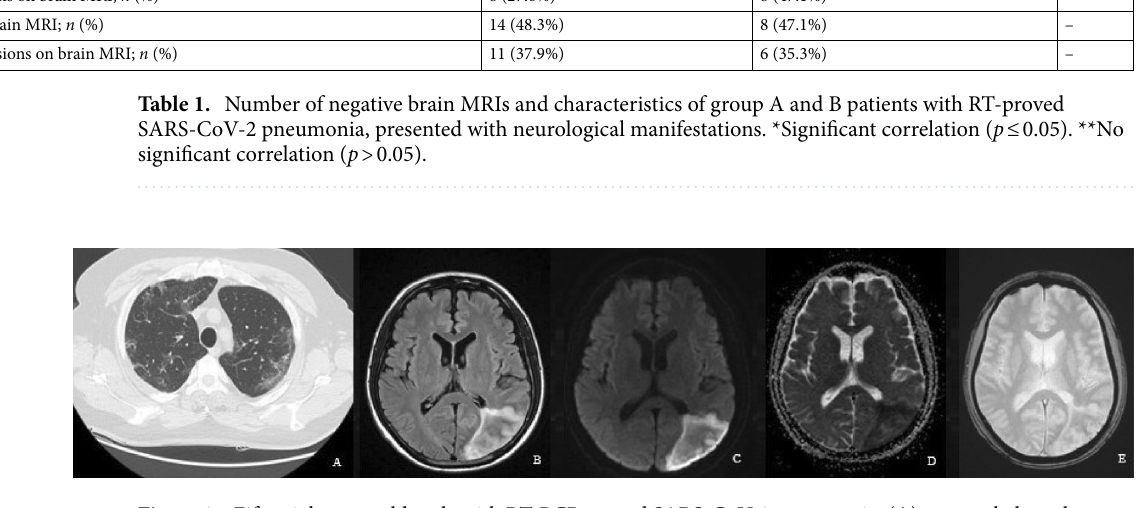
Figure 3. Fifty-eight-year-old male with RT-PCR proved SARS-CoV-2 pneumonia, ( A ) as revealed on chest CT. The patient also had right-sided weakness, right hemihyposthesia, and aphasia (stroke). Brain MRI was performed 4 days after the onset of the focal neurological manifestations as brain CT scanning was performed at the onset of such manifestations. ( B ) Axial FLAIR image showed increased signal intensity in the left parieto- occipital lobe ( C ) DW-MRI and ( D ) corresponding apparent diffusion coefficient (ADC) map showed diffusion restriction of the early sub-acute left parieto-occipital infarction. ( E ) No blooming was seen on two-dimensional (2D) T 2 * gradient-echo sequences (GRE), signifying no hemorrhage.